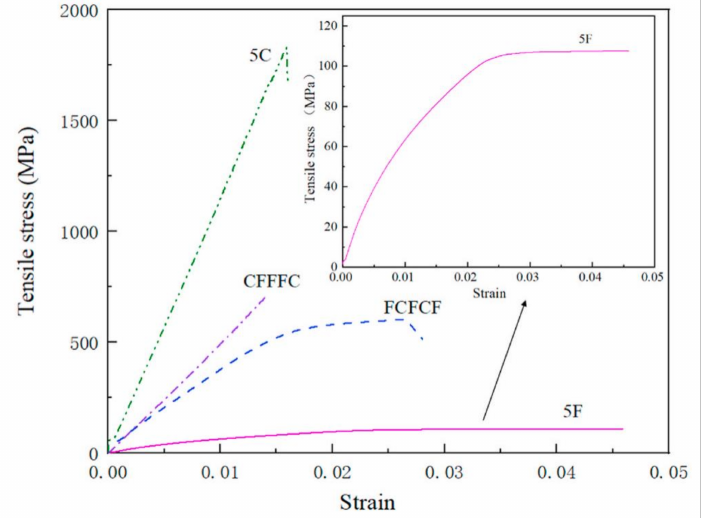
Figure 2. Tensile stress-strain curve of flax/carbon hybrid composite laminates (adapted with permission Elsevier, 2022)